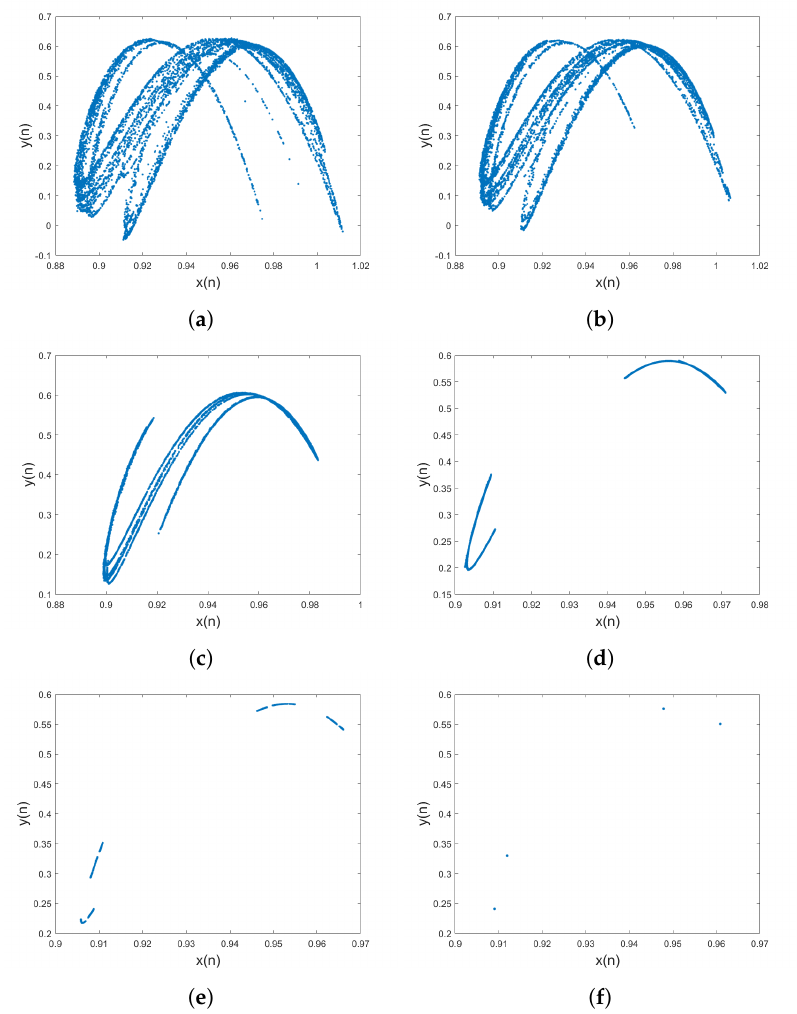
Figure 2. Phase portraits of (3) for a = 2.5, b = 5, c = 5.5, δ = 1.05 and with ( a ) γ = 0.67, ( b ) γ = 0.7, ( c ) γ = 0.8, ( d ) γ = 0.85, ( e ) γ = 0.9, ( f ) γ =